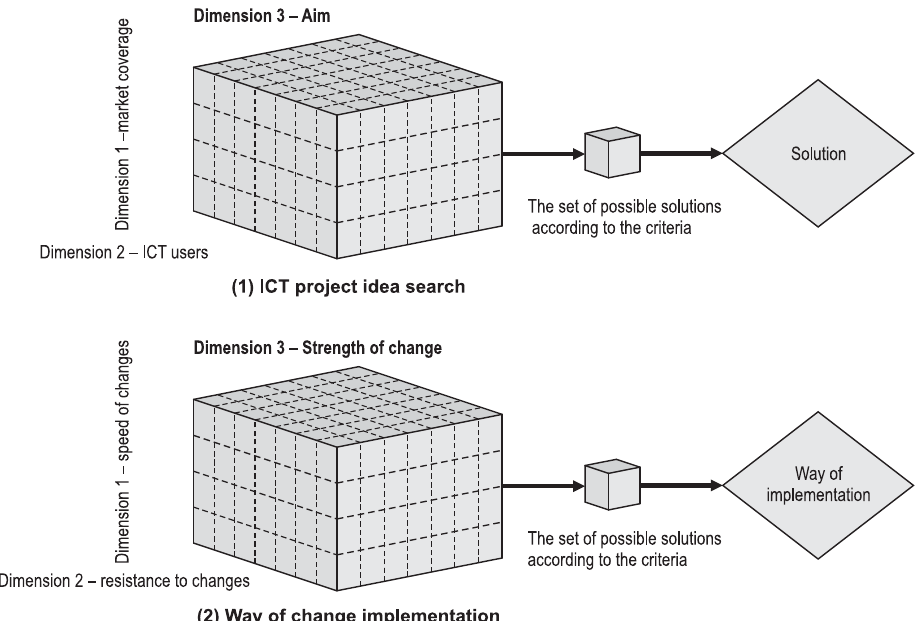
Fig. 2. Ways of ICT solution search (Elskytė